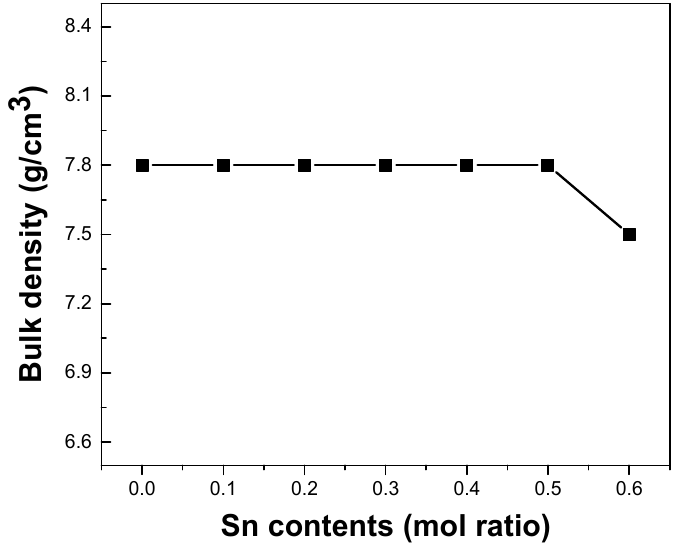
Figure 4. Sintered density of (Pb 0.88 , La0 .12 )(Zr 1 − x , Sn x ) 0.86 Ti 0.14 O 3 + ZnO (2 wt%) + PbO (8 wt%) composition at 950 ◦ C, according to Sn 4+ substitution.